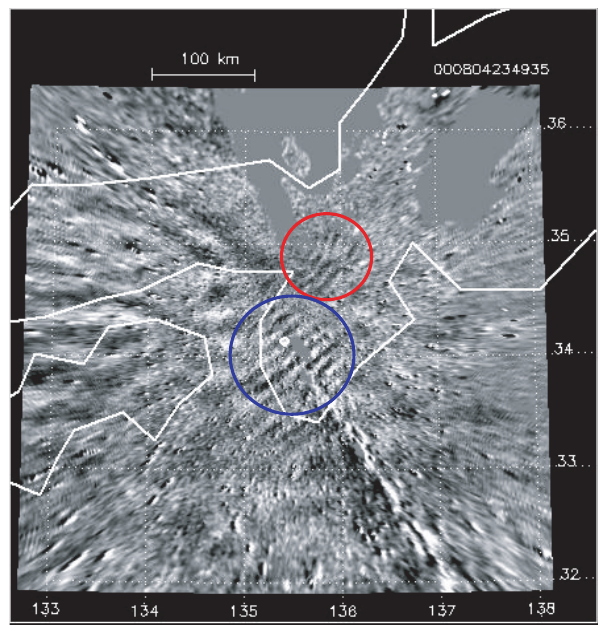
Fig. 1. Two ripples denoted inside the red and blue circle at the center of the 500 × 500km geographic map. The image was taken by the Misato imager at 23:49UT on 4 August 2000. Longitudes and latitudes are marked on the side. The white curve is the Japanese coast